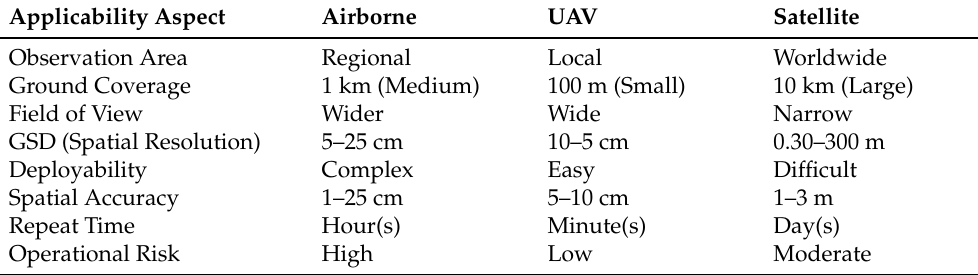
Table 4. Key differences between spectral image